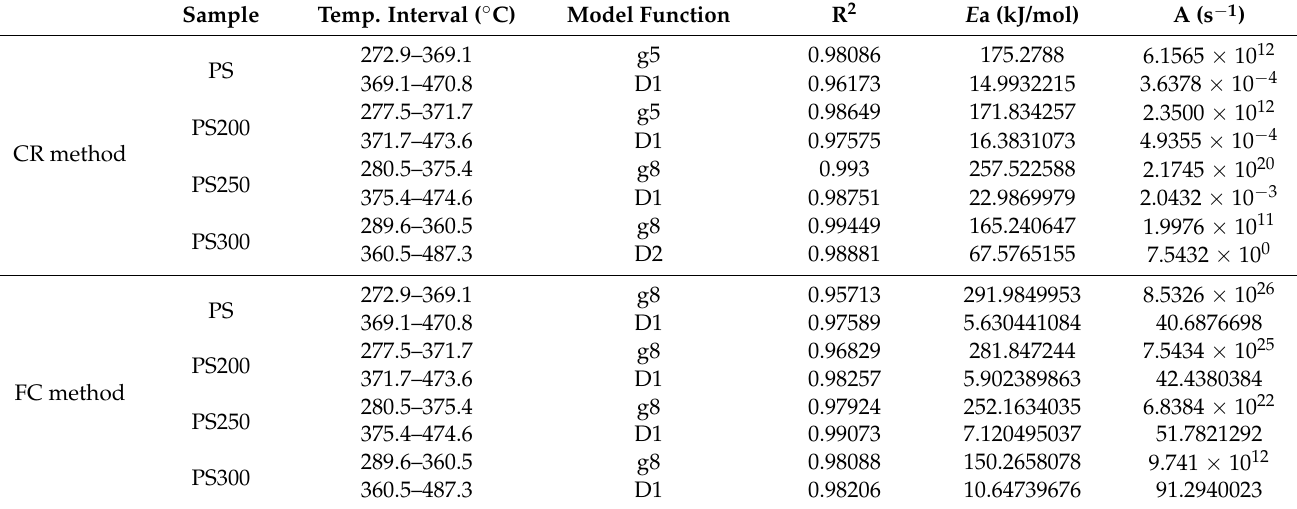
Table 2. Kinetic parameters of the raw and torrefied